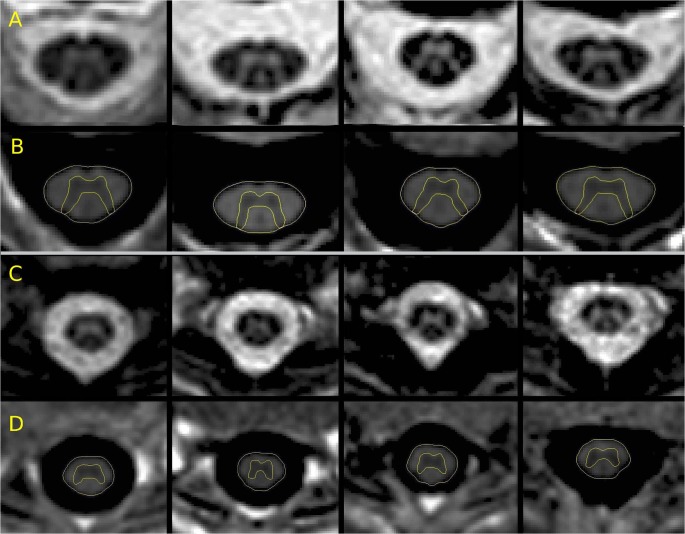
C2-C3 and T9-T10 segmentation examples on 4 healthy subjects.Images acquired for 4 different healthy subjects: A and B: C2-C3 level; C and D: T9-T10 level. In rows A and C the magnitude reconstructions are reported to appreciate the quality of the acquisitions, while in rows B and D the phase-sensitive reconstructed images that were used for both the total cross-sectional area (TCA) and gray matter (GM) segmentations (yellow) are reported. Phase-sensitive reconstructed images allowed good intra- and inter-operator reliability of both the area measurements on a single image.